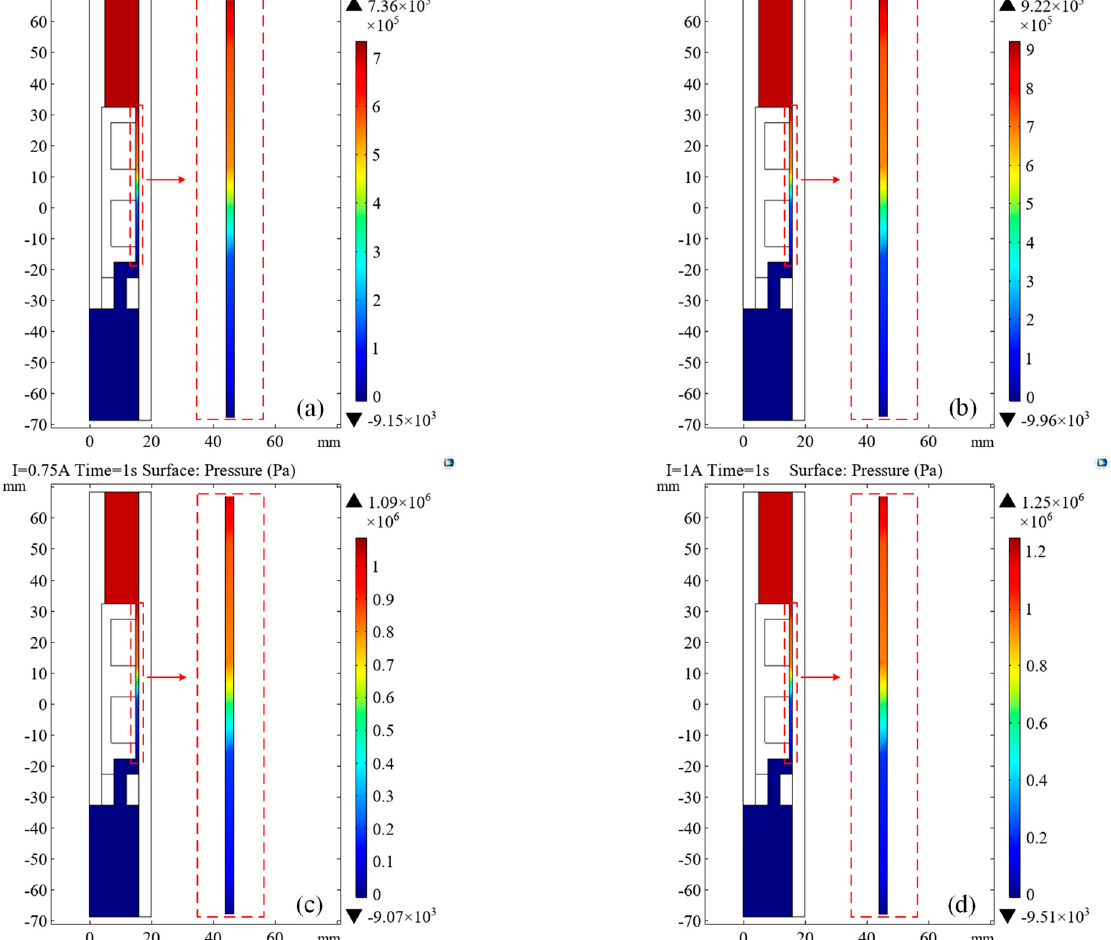
0.25, 0.5, 0.75, and 1 A). In the damping gap, the fluid velocity in adjacent regions of the